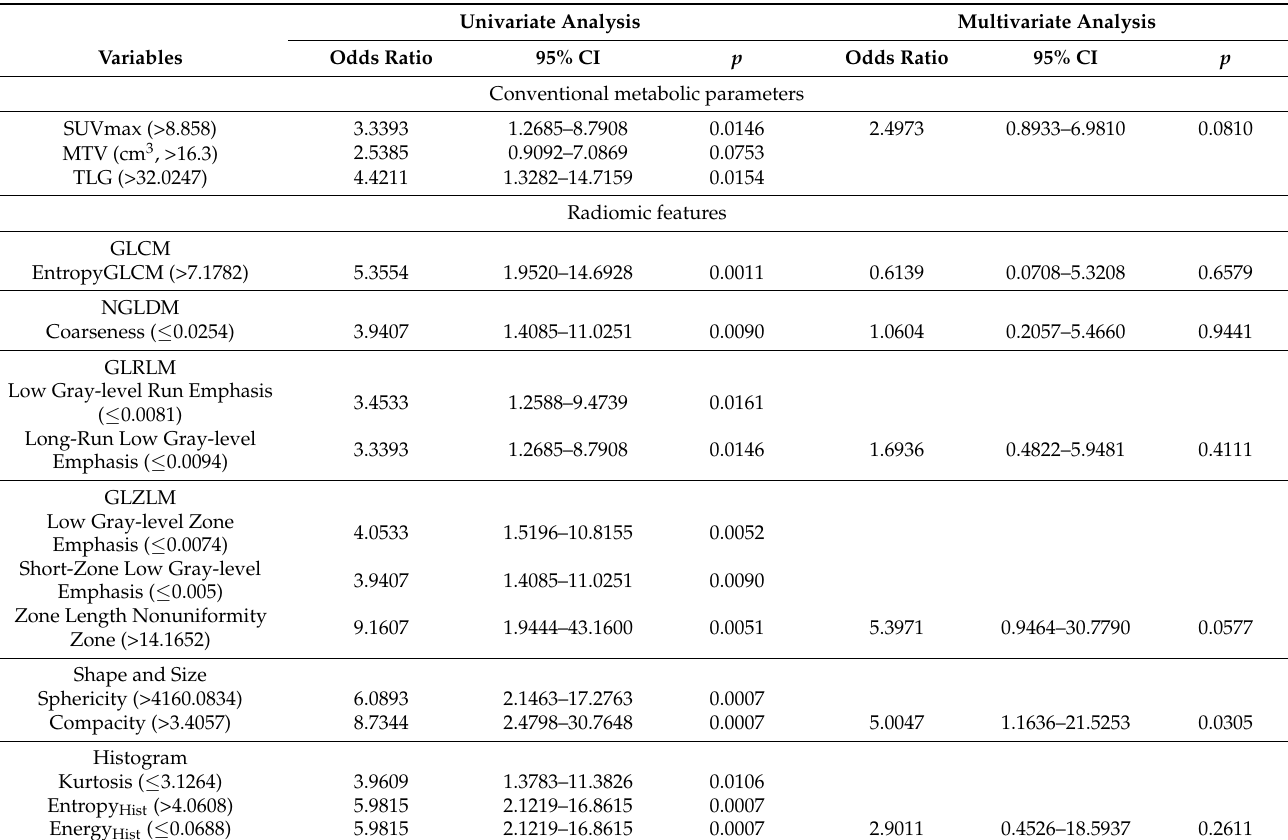
Table 3. Multiple logistic regression analysis for the evaluation of the correlation between radiomic features and intratumor budding